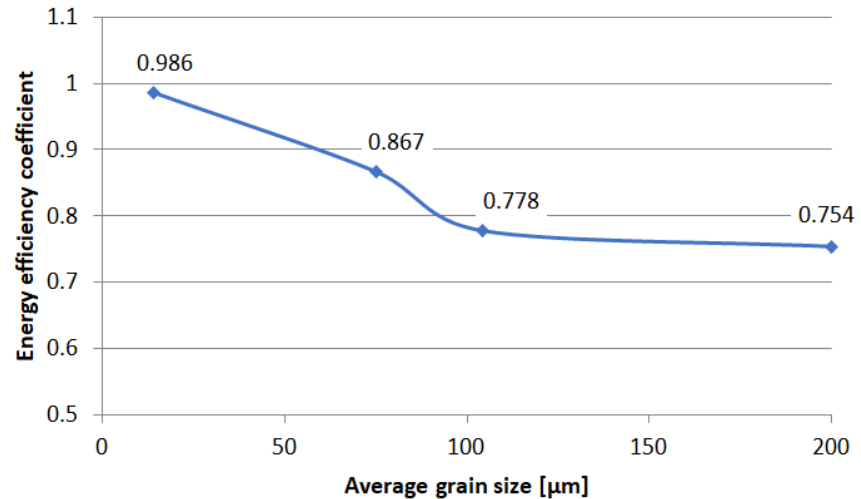
ffi ciency coe ffi cient for di ff erent grain sizes of polycrystal Figure 8. Computed energy efficiency coefficient for different grain sizes of polycrystal copper. Figure 8. Computed energy e